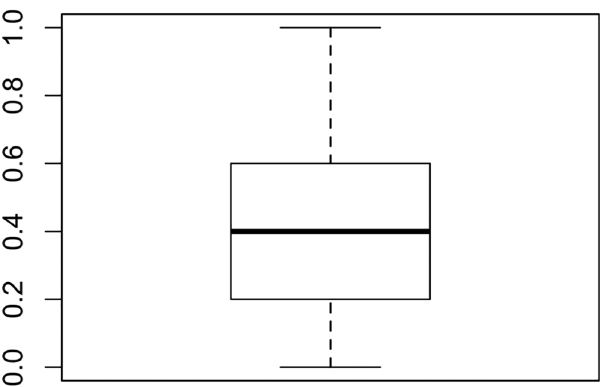
Figure 1. Gower model optimal clusters. Source: self-made by authors.